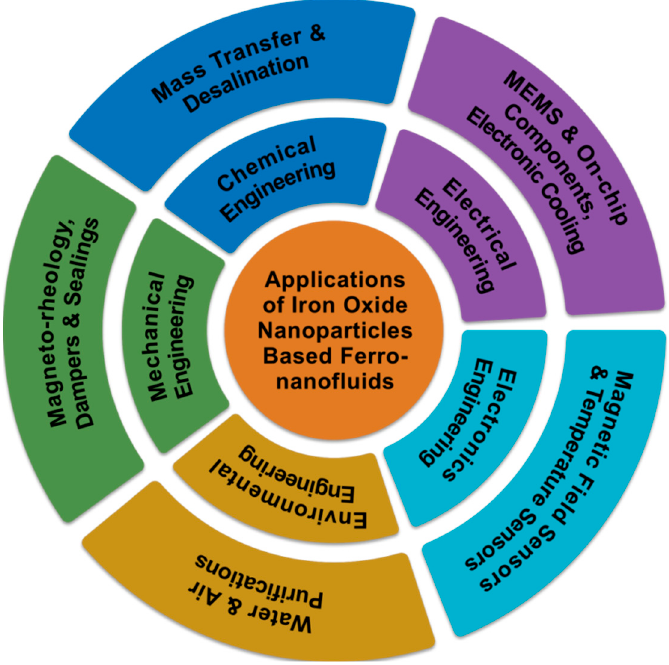
Figure 1. Various advanced technological applications of ION − based FNs concerning different engineering fields.